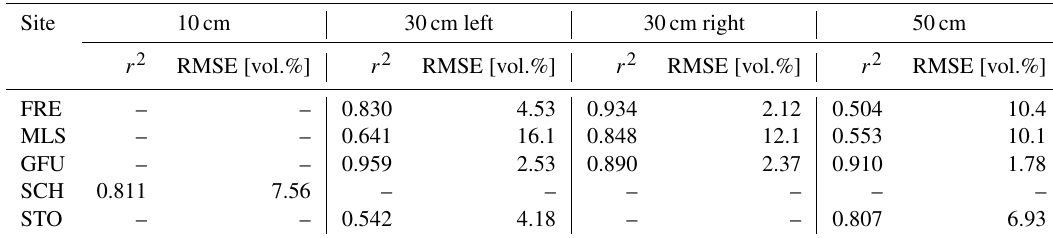
Figure 6. SMT100 measured LSM (upper panel) and ground temperatures (lower panel) at each SOMOMOUNT station (a–f) . At FRE the uppermost panel displays the PR2/6 measured LSM. The vertical dotted lines at FRE and SCH indicate the period analysed in Fig. 7. The dashed LSM lines represent the soil moisture measurements taken when the ground temperature was below 1 ◦ C. Table 5. Correlation ( r 2 ) and RMSE between the PICO64 and SMT100 measured LSM at all